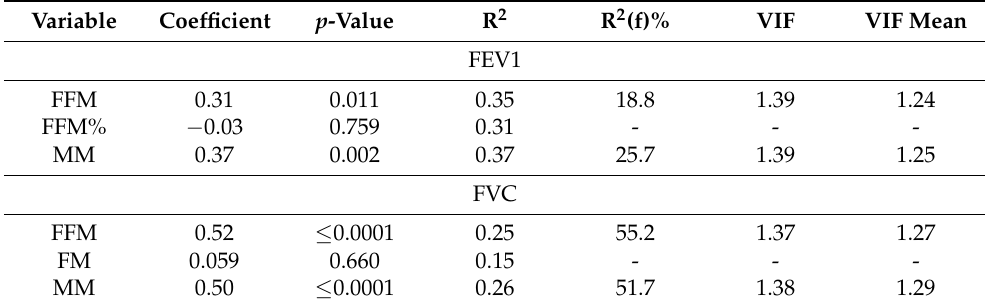
Table 5. Multivariate analysis in female